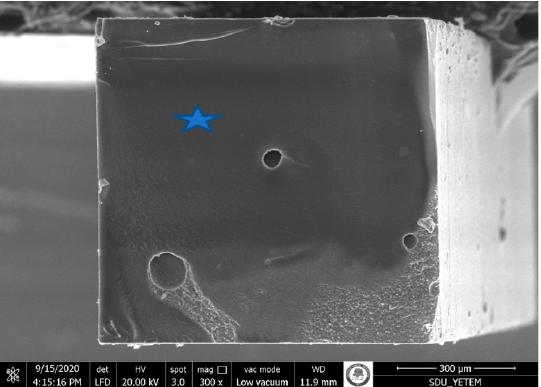
Figure 2. SEM photomicrograph of the fracture surface (aged composite side). The specimen was obtained from 6 months aging of nanohybrid composite, sandblasting, silane applied, Scotchbond Universal group. An adhesive failure pattern was revealed. AL: Adhesive layer on the aged composite surface. RC: Fresh resin composite on the aged composite surface. Note the smooth surface, which did not contribute to micro-mechanical retention (*).